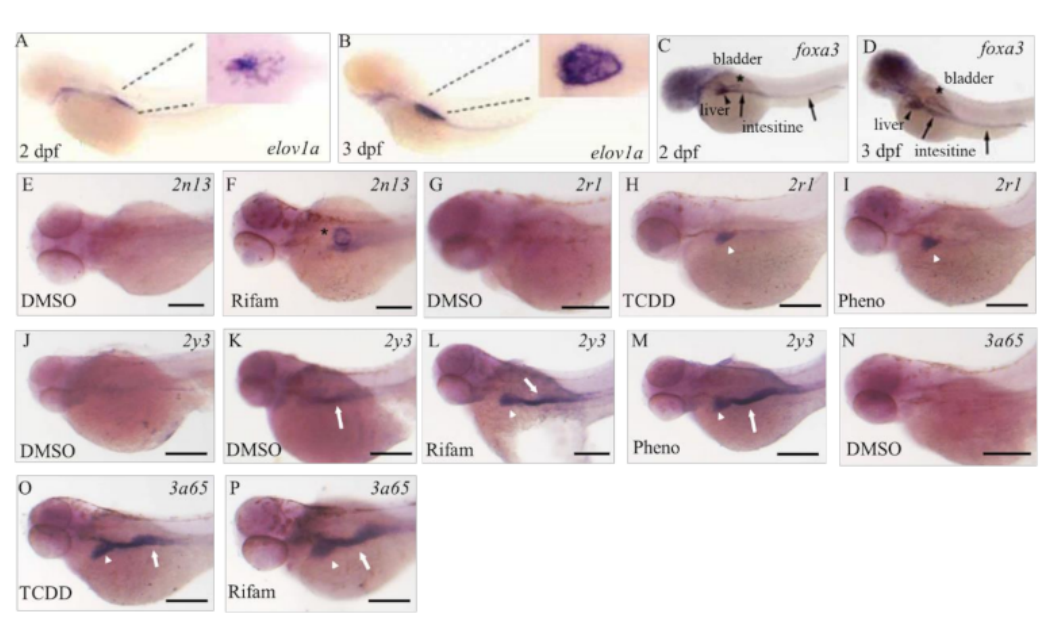
Figure 4. Spatial expression of mRNAs of CYP subtypes. Zebrafish embryos were exposed to 100 µ M rifampicin (Rifam; ( F , L , P )), 100 µ M phenobarbital (Pheno; ( I , M )), or 1.0 ppb TCDD ( H , O ) and 0.1% dimethyl sulfoxide (DMSO) as vehicle control (DMSO; ( E , G , J , K , N )). ( A , B ) are published images of elov1a , a marker of the primordial bladder (( A ) at 2 days post-fertilization [dpf], ( B ) at 3 dpf) [37]. ( C , D ) are published images of foxa3 , a marker of the primordial liver (black arrowheads) and intestine (black arrows) and bladder (asterisks) (( C ) at 2 dpf, ( D ) at 3 dpf) [38]. Larval zebrafish (55 hpf) were used for whole-mount in situ hybridization with RNA probes for cyp2n13 ( E , F ), cyp2r1 ( G – I ), cyp2y3 ( J – M ), and cyp3a65 ( N – P ). Asterisks indicate possible bladder primordium ( F ) and white arrowheads and arrows indicate possible primordia of the liver and intestine, respectively ( H – P ). Scale bars in ( E – P ) indicate 200 µ m. ( A – D ) are reproduced from previous reports ([37] for ( A , B ), and [38] for ( C , D